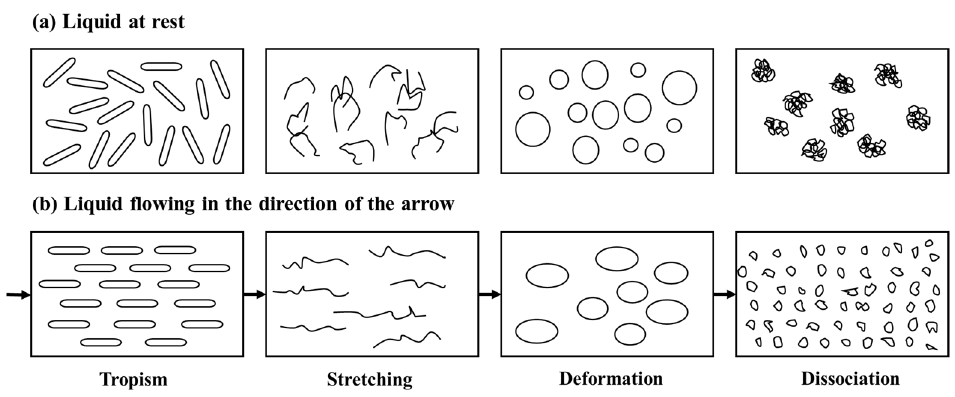
Figure 2. The relationship between the apparent viscosity of SMG aqueous dispersion and shear rate.